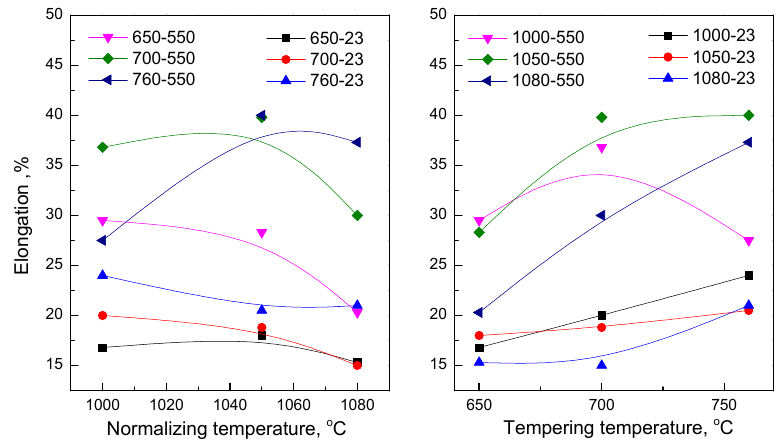
Figure 10. Tensile strength of 15Cr12MoVWN steel under different heat treatment conditions.